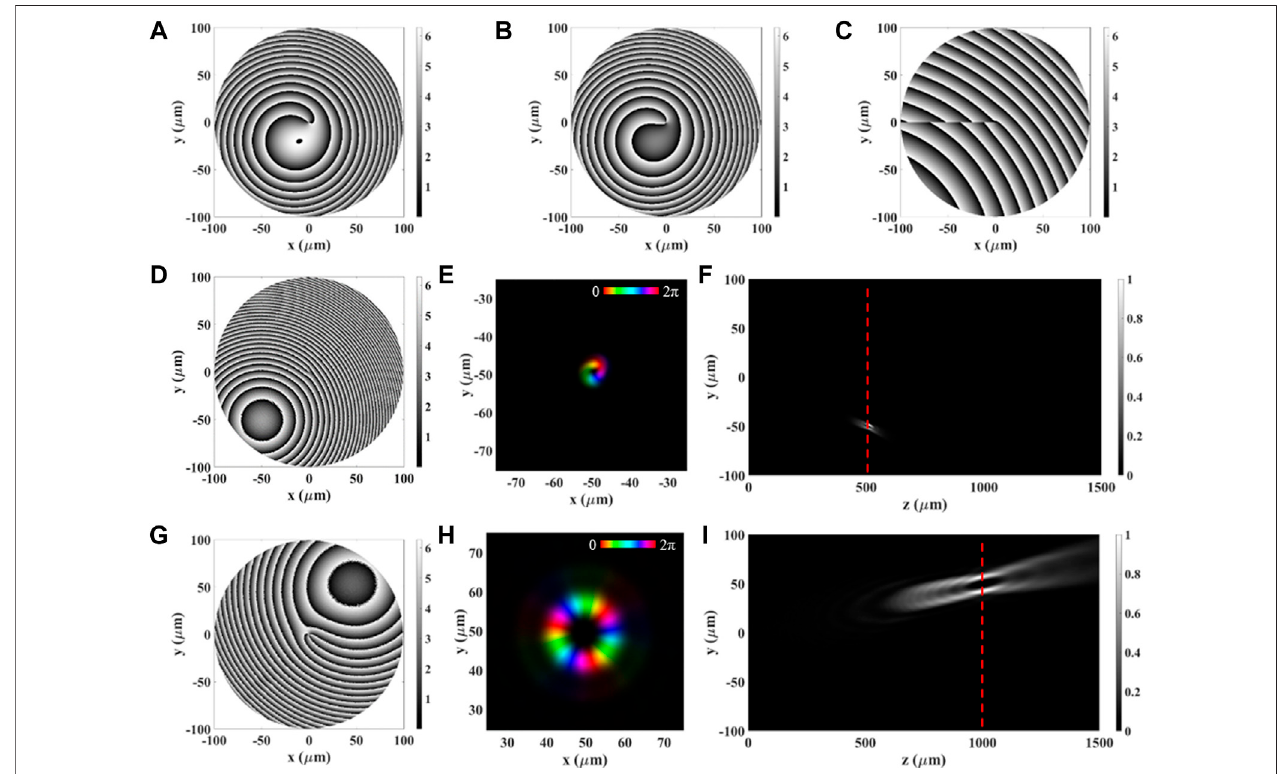
FIGURE 7 | Simulations of DFML implementing Eqs 20 , 21 . (A – C) ML design phase maps of δ x (A) , δ y (B) , and θ (C) from Eqs 7 – 9 . (D,G) show ϕ + and ϕ − phase maps, respectively. (E) Intensity and phase of the propagated fi eld under LCP polarization at z (cid:2) 500µm. (F) Intensity cross-section ( yz -plane, from 0 to 1.5 mm, x = − 50 µm) under LCP polarization. (H) Intensity and phase of the propagated fi eld under RCP polarization at z (cid:2) 1000µm. (I) Intensity cross-section ( yz -plane from 0 to 1.5 mm, x = +50 µm) under RCP polarization. In (E,H) , brightness and colours refer to intensity and phase, respectively.